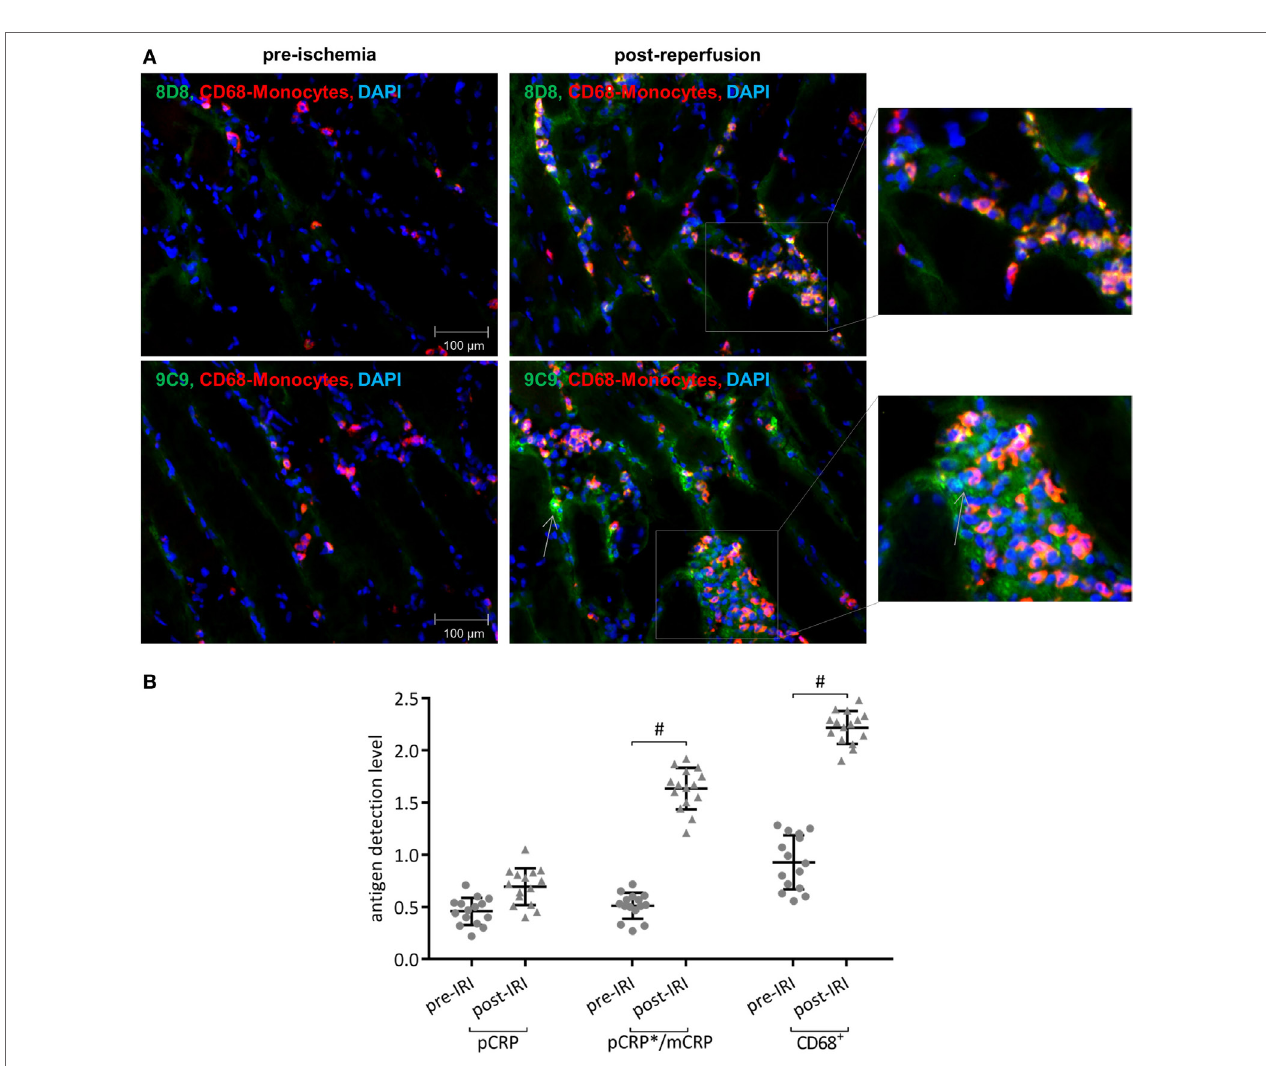
FigUre 5 | Conformationally altered C-reactive protein (CRP) accumulates in inflamed human muscle tissue. (a) Immunofluorescence conformation-specific detection of C-reactive protein and CD68 + cells in striated human muscle tissue shortly before (pre-ischemia) and after free tissue transfer (post-reperfusion). Conformation-specific antibody clone 8D8, which recognizes exclusively pentameric C-reactive protein (pCRP) and clone 9C9, recognizing neo-epitopes expressed by pCRP*/monomeric C-reactive protein (mCRP), were used. Typical results are given. (B) Quantification shows relative values of immunoreactivity for CD68 + cells and pCRP and pCRP*/mCRP, respectively. At least three non-overlapping images were evaluated from each sample to determine the corresponding value. # p < 0.05 for pre-ischemia vs. ischemia/reperfusion injury (IRI). Values are mean ± SEM; n = 15. IRI leads to a significant increase of p- and especially conformationally altered CRP deposition, which co-localizes with CD68 + leukocytes.